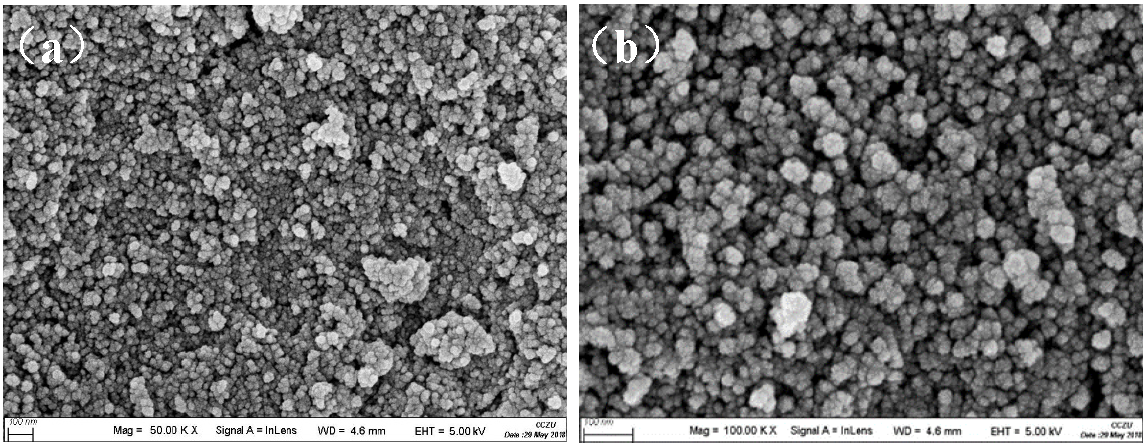
Figure 7. SEM image of silica aerogel powders at ( a ) 50.00 KX and ( b ) 100.00 KX magnification.